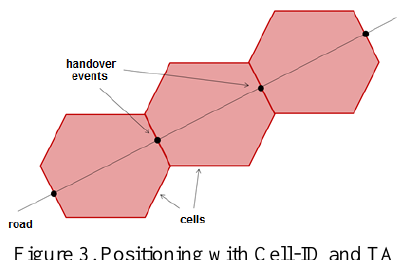
Figure 3. Positioning with Cell-ID and